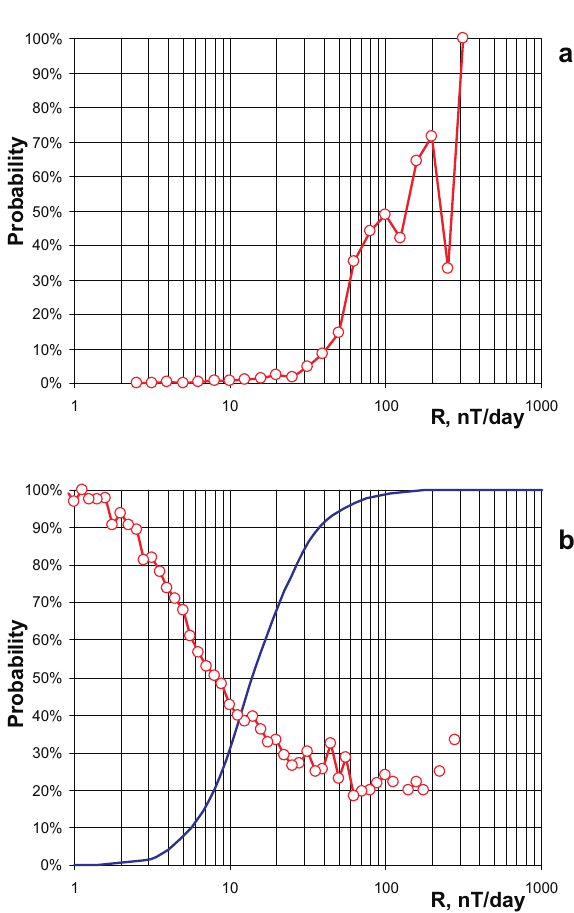
Fig. 3. Conditional probabilities for Eskdalemuir: (a) P (R(k + 1 ) > 50nT/day | R(k)) ; (b) P (R(k + 1 ) > R(k) | R(k)) , and the empirical distribution of R (blue line), i.e. unconditional probability P (R(k + 1 ) ≤ R) .